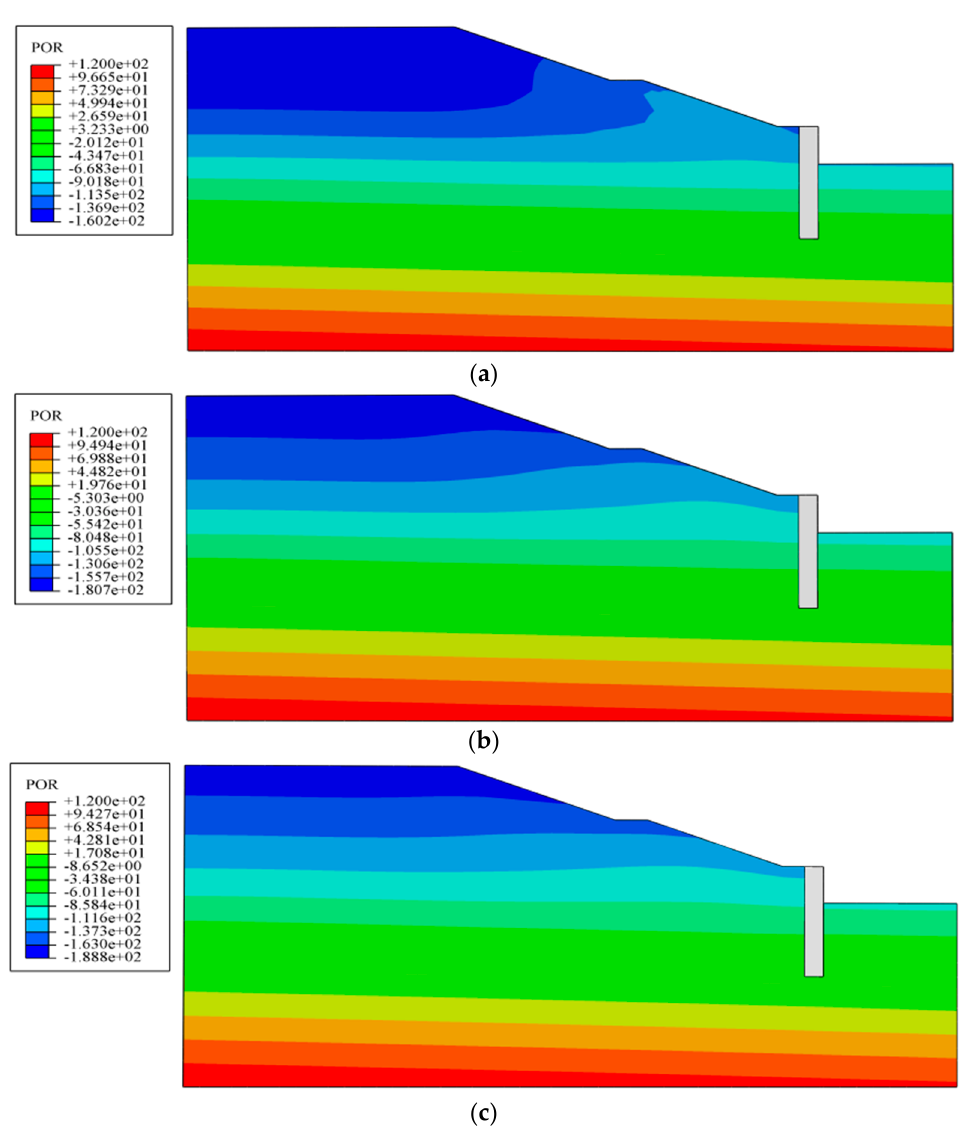
Figure 10. The PWP contours (unit: kPa) of the cutting slope under the snowmelt infiltration: ( a ) t = 48 h; ( b ) t = 72 h; and ( c ) t = 96 h.